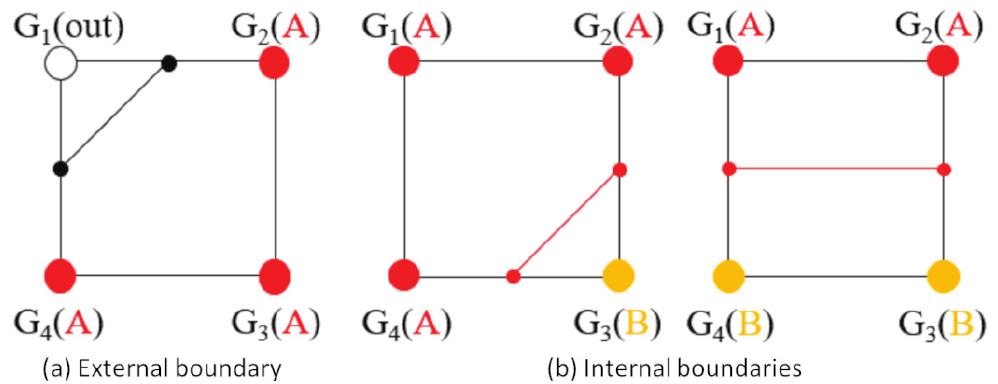
Figure 7. Development of contour lines in cells with ‘G’ representing grid-nodes on a slicing plane. ( a ) External boundary, ( b ) Internal